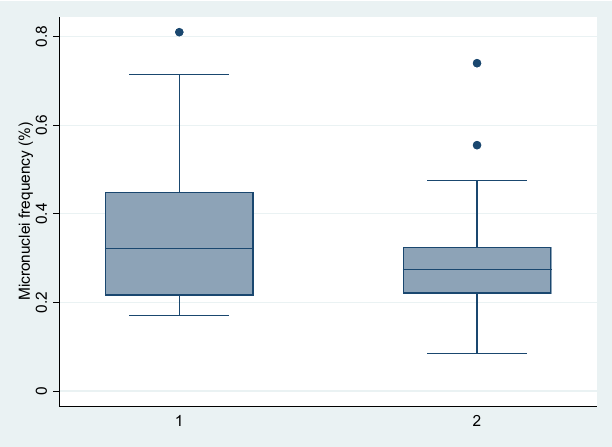
Figure 4. Micronuclei levels in children’s buccal cells in children attending school 1 (near a steel factory) and those attending schools at other sites.